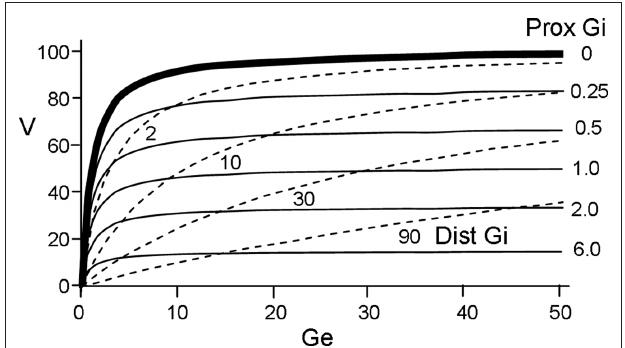
FigurE 1 | relationship between depolarization ( V) and excitatory and inhibitory conductances ( G and G ). Solid curves plot depolarization as a e i function of G for various values of G assuming proximal inhibition ( V for distal e i inhibition is given by dashed